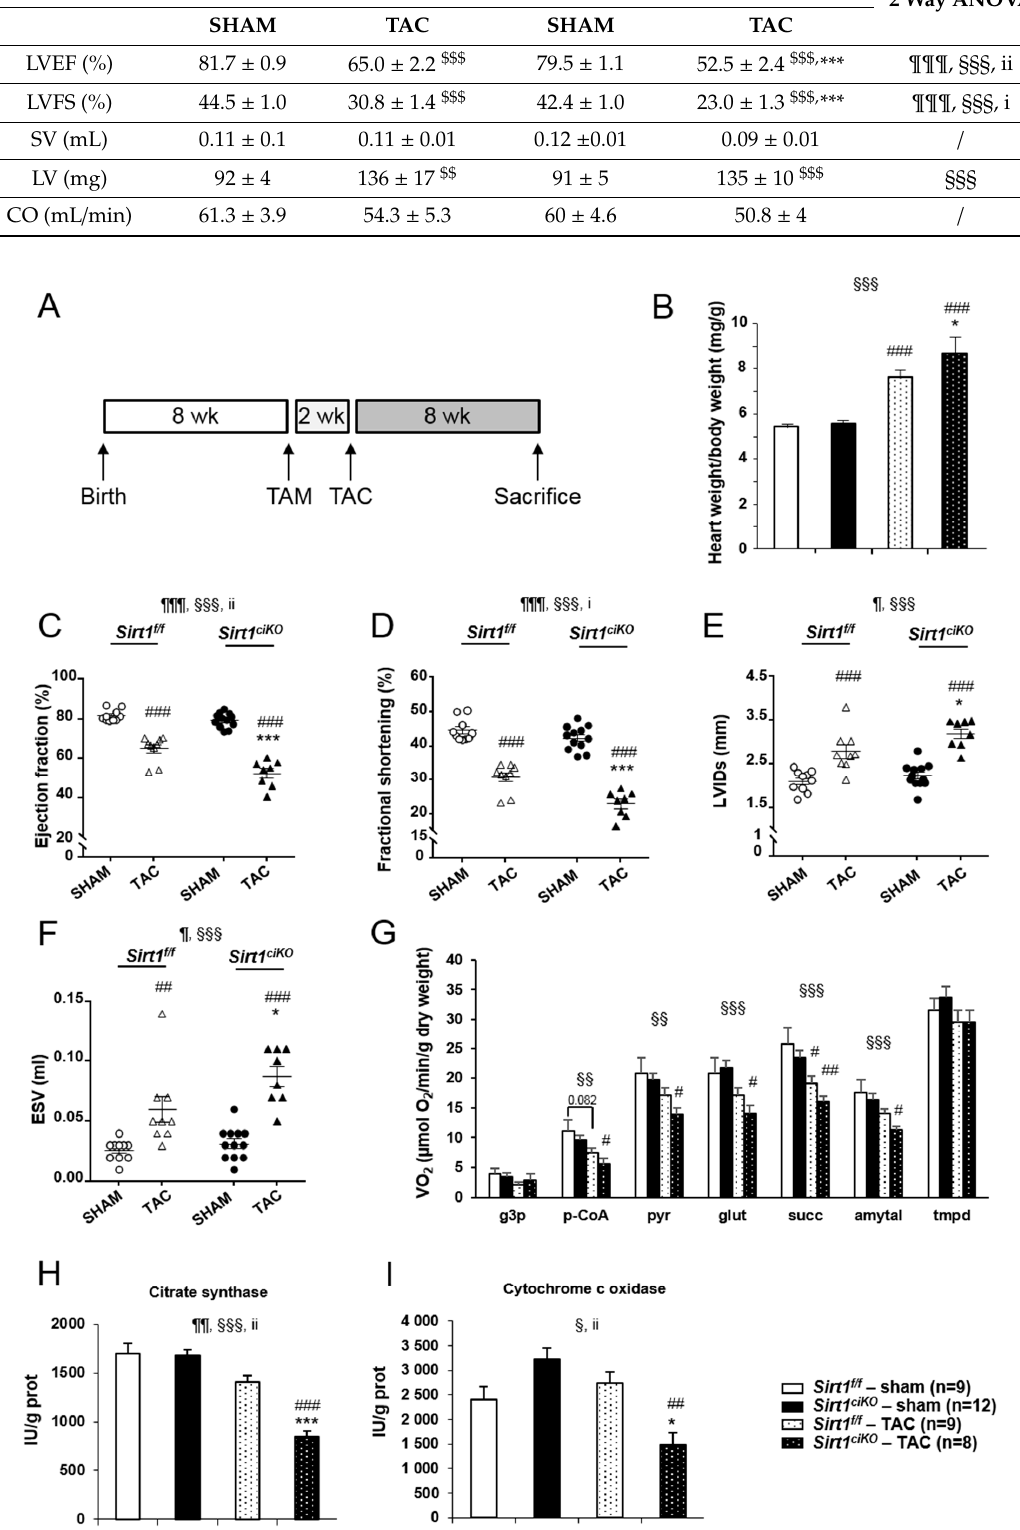
Figure 6. Cardiac phenotype of cardiac-specific knockout mice after 8 weeks of cardiac pressure overload. ( A ) Two weeks after tamoxifen injection, mice were subjected to surgery (TAC and sham) and were sacrificed 8 weeks later. ( B ) Heart weight-to-body weight ratio at sacrifice. ( C ) Left ventricular ejection fraction just before sacrifice. ( D ) Left ventricular fractional shortening just before sacrifice. ( E ) Left ventricular internal dimension at end-systole (LVIDs) just before sacrifice. ( F ) Telesystolic LV volume (ESV) just before sacrifice. ( G ) Rate of respiration after successive addition of L-glycerol-3-phosphate (4 mM) (g3p), palmitoyl-CoA and carnitine (100 µM and 2 mM) (p-CoA), pyruvate (1 mM) (pyr), glutamate (10 mM) (glu), succinate (15 mM) (succ), amytal (1 mM), and TMPD-ascorbate (0.5 mM). ( H ) Citrate synthase (CS) enzymatic activity. ( I ) Cytochrome c oxidase (COX) enzymatic activity. ( n = 8 to 12 per experimental group), ANOVA: ¶ p ≤ 0.05, ¶¶ p ≤ 0.01, ¶¶¶